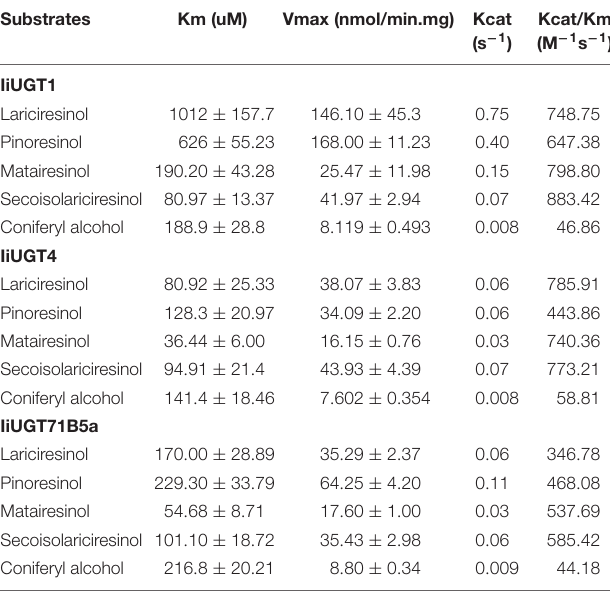
TABLE 1 | Kinetic parameters of candidate recombinant